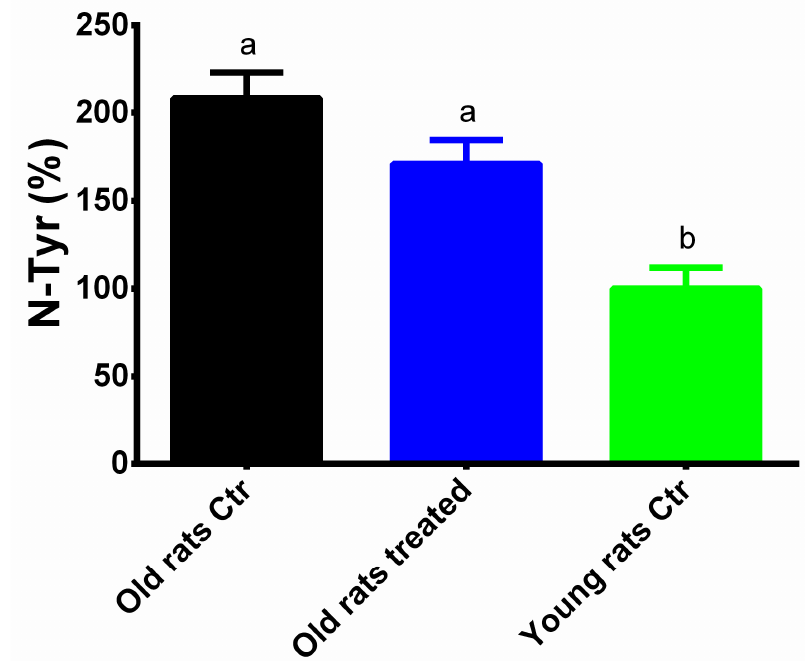
Figure 6. Levels of N-Tyr. Results are expressed as mean ± SEM, and p < 0.05 was considered statistically significant. Statistical significance was calculated by one-way ANOVA analysis. Different letters reveal significant differences. Old rats Ctr refers to old animals treated with placebo; Old rats treated refers to old animals treated with Taurisolo ® ; Young rats Ctr refers to young animals treated with placebo. Abbreviations: N-Tyr, nitrotyrosine.